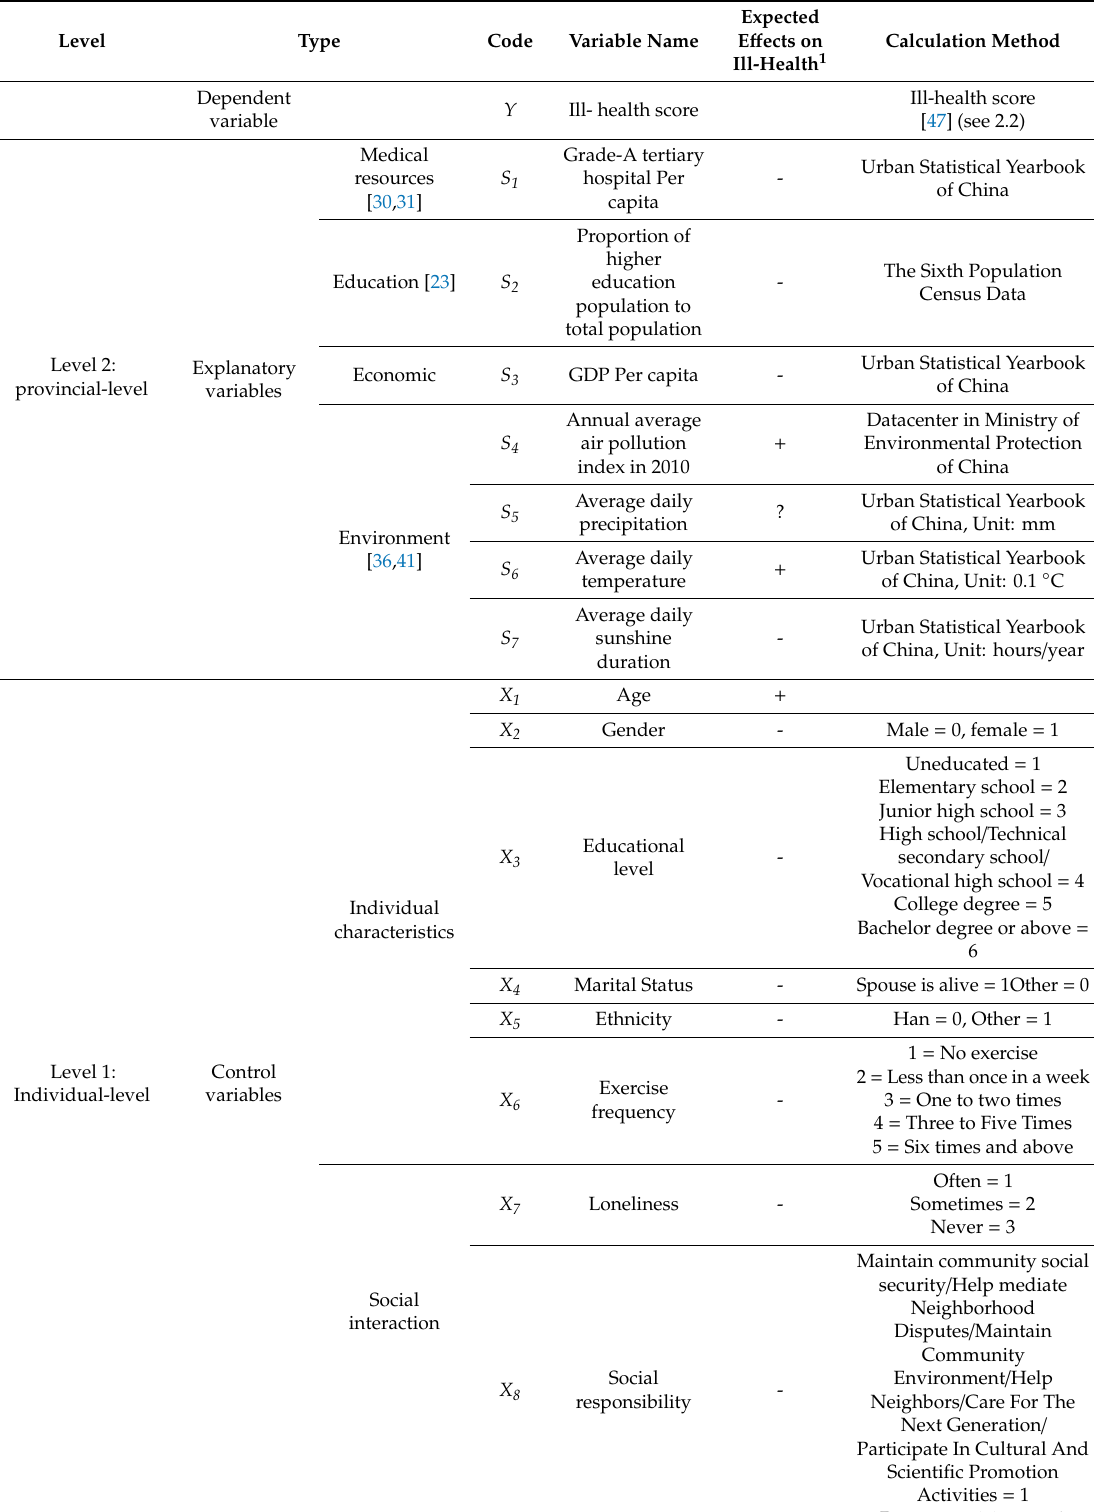
Table 1. Description of Variables and Expected E ff